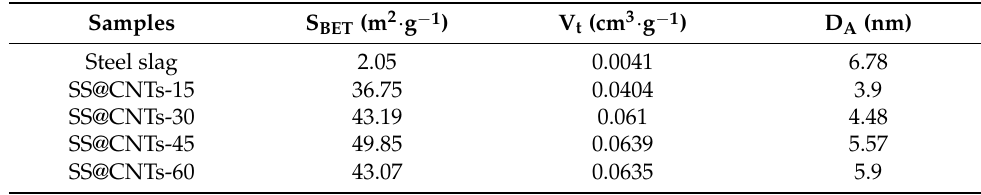
Table 3. The BET surface areas and porosity characters of SS@CNTs synthesized using different time